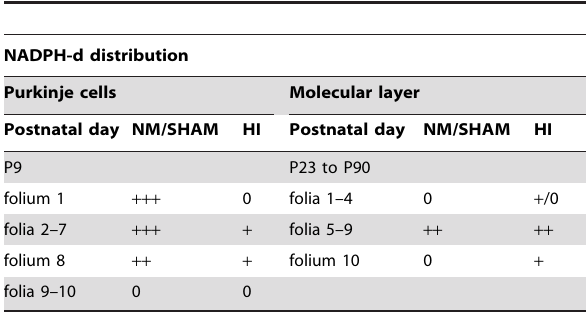
Table 1. Distribution of NADPH-d + cells in the cerebellar gray matter.